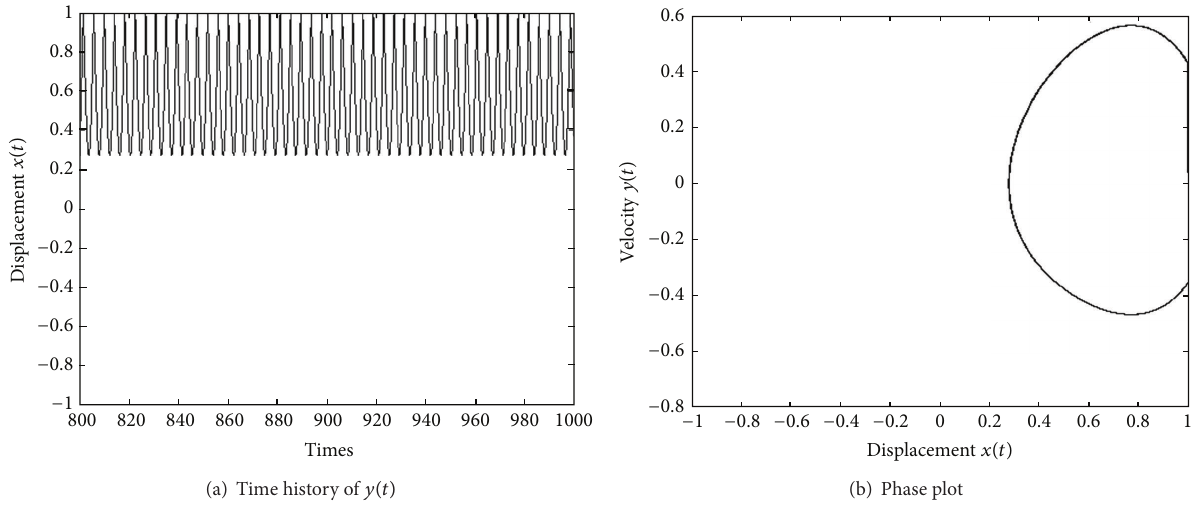
Figure 3: Numerical results of (1) ( 𝑓 1 = 2.5, 𝑓 2 = 0.0, 𝑥(0) = −0.4, ̇𝑥(0) = 2.5 ).